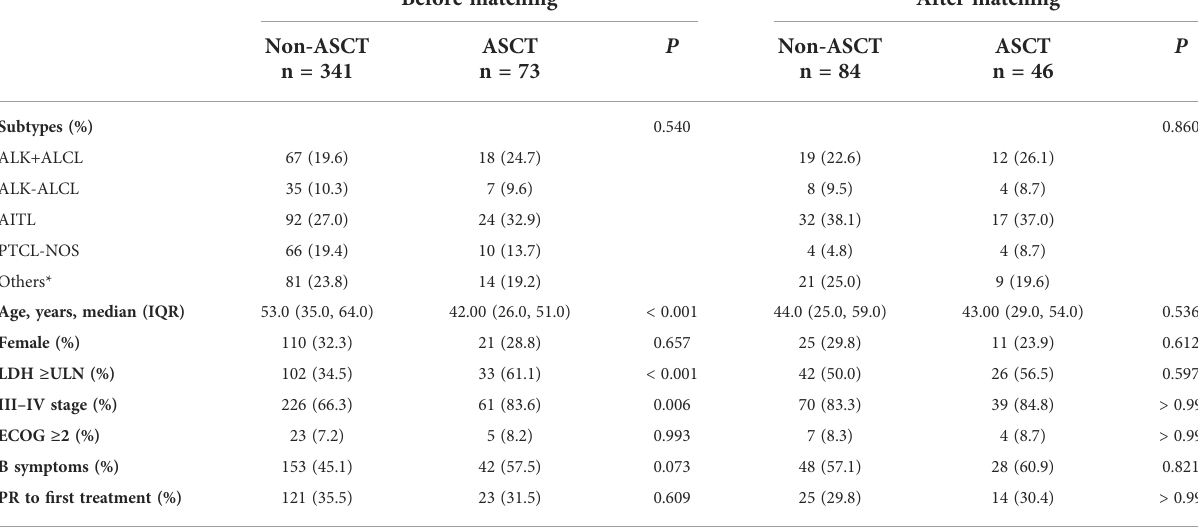
TABLE 1 Baseline characteristics of patients in the ASCT group and the non-ASCT